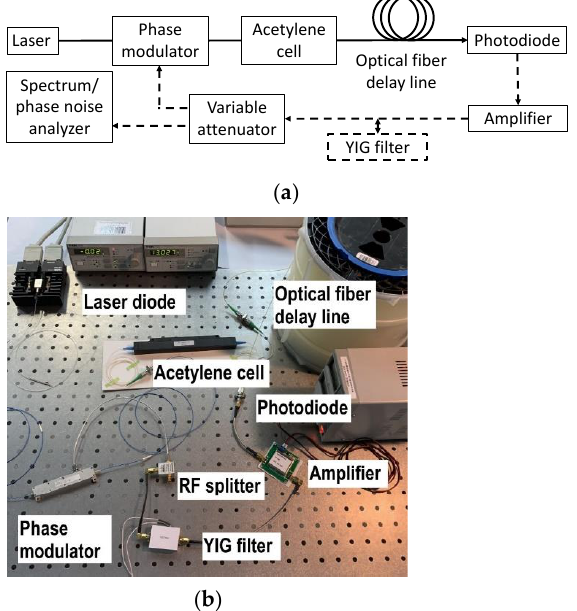
Figure 1. ( a ) A schematic diagram of the OEO under consideration, and ( b ) a photograph of the experimental setup.